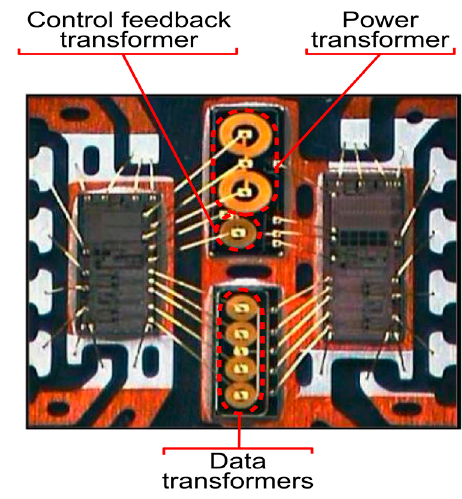
Figure 4. Die photograph of an isolated DC-DC converter with data links. Reproduced from [10]. Copyright 2008, IEEE.